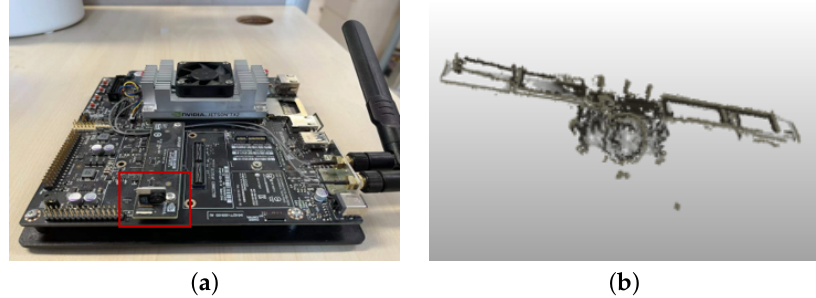
Figure 5. TX2 simulation system: ( a ) Camera on TX2. ( b ) Actual visual point